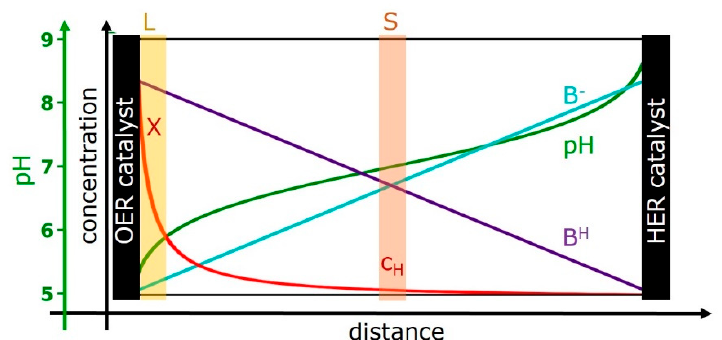
Figure 1. Cross-section of an idealized electrochemical cell with spatial concentration profiles of the protonated form of the buffer base (B H , violet line), its deprotonated form (B − , cyan line), and the proton concentration (red line). The corresponding pH profile also is indicated (green line). The scaling of the concentration axis for B H and B − differs from the scaling used for the proton concentration; a typical maximal B H concentration would be in the range of 100 mM to 1 M (e.g., of phosphate buffer). The distance between the anode (oxygen-evolution reaction (OER) catalyst) and cathode (HER catalyst) could be, e.g., 1 cm. The OER catalyst is clearly thinner than drawn in the scheme, e.g., 500 nm. The “buffer layer” at the catalyst—solvent interface—is marked by L and highlighted by a yellow-brown area. The value of X provides the proton concentration or more precisely the proton activity directly at the surface of the OER catalyst. The proton concentration (activity) in the bulk solvent without any flow of catalytic currents is denoted as c H . For operation at catalytic conditions, the proton concentration in the bulk solvent is equal to c H only within a specific plane between anode and cathode, which is highlighted by a light-red area and marked by S. The shown concentrations profiles are an example; their form is in line with the proton transport model developed in the following, for an electrolyte filling the space between two parallel electrodes. In the shown example, we assume that c H equals K aB and corresponds to a pH of 7.